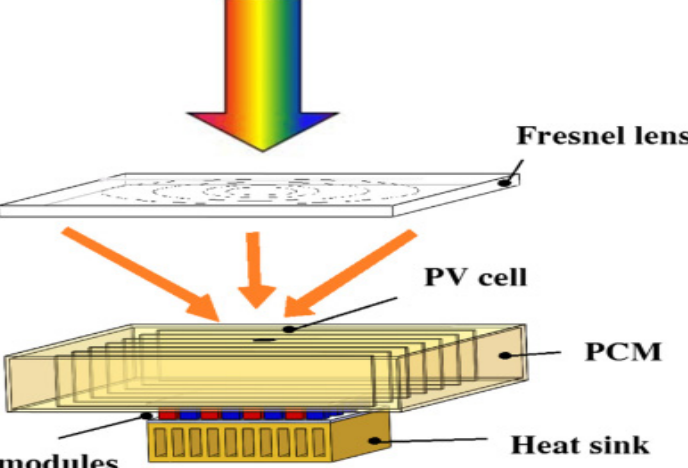
Figure 19. Details of the experimental setup studied by Cui et al. [88]. Adapted with permission from Elsevier.